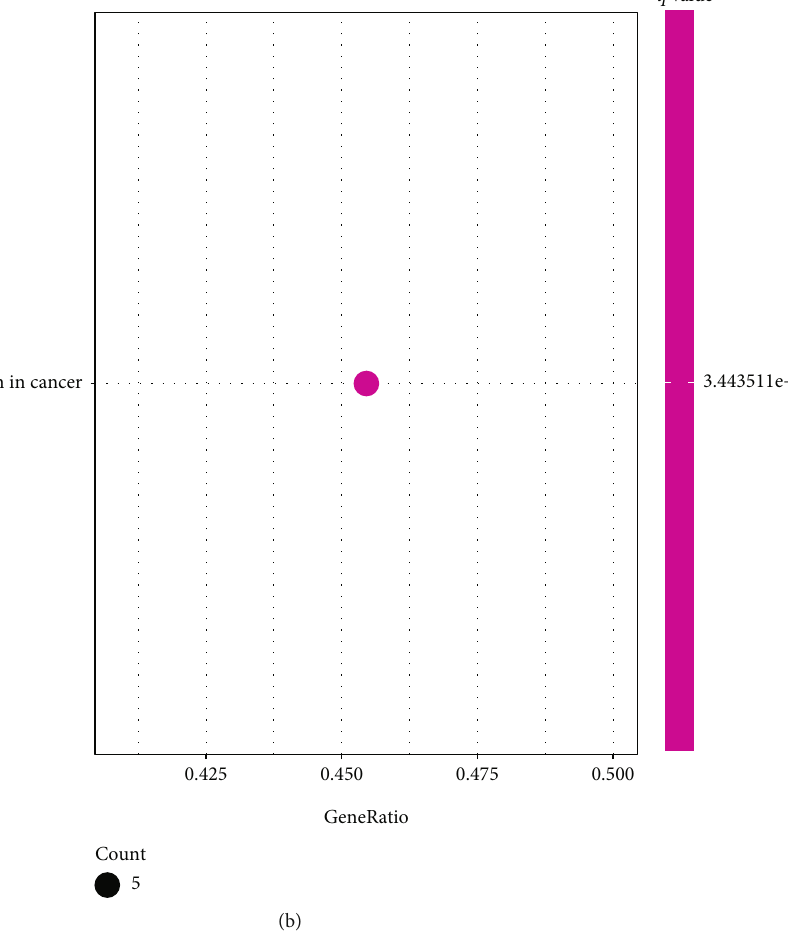
Figure 2: Functional analysis based on the dysregulated TFs between the two risk groups in PAAD. (a) Bubble graph for GO enrichment. (b) Bar plot graph for KEGG